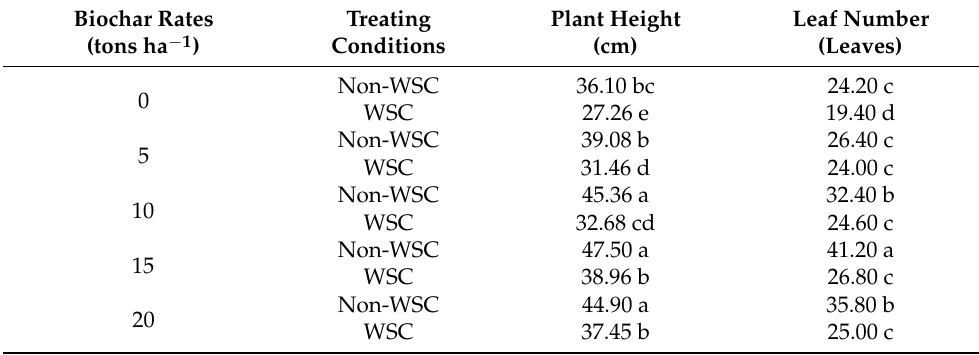
Table 3. Effect of biochar on plant height and number of leaves of Ehretia asperula under non-WSC and WSC.